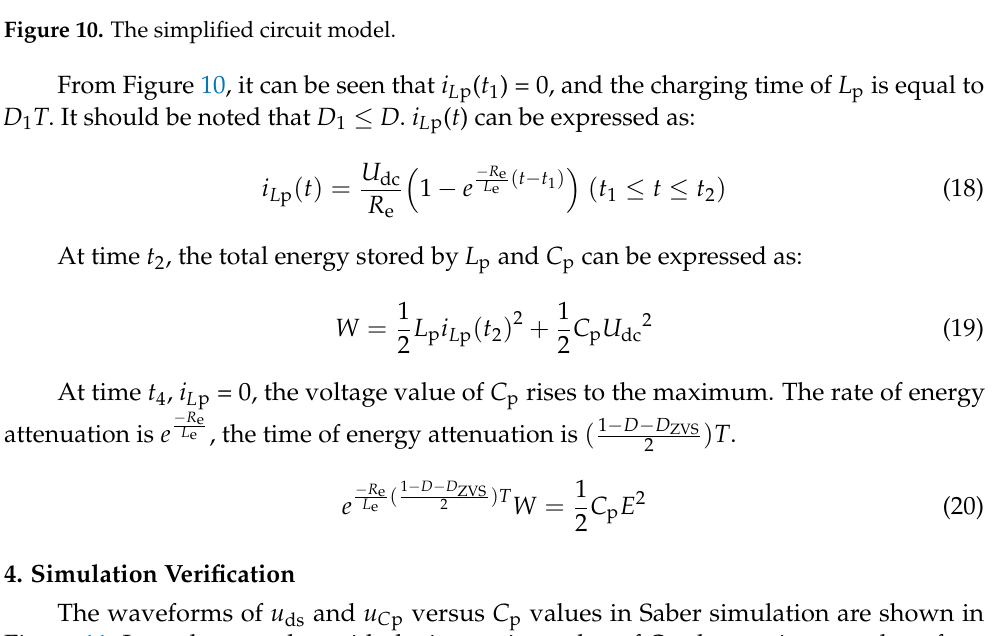
The waveforms of u ds and u C p versus C p values in Saber simulation are shown in Figure 11. It can be seen that with the increasing value of C p , the maximum value of u ds decreases gradually, and the ZVS margin D ZVS decreases until it disappears. The theoretical calculation in Section 3 provides the basis for the actual value of C p . When the input DC voltage is 96 V and the switching frequency f is 85 kHz, in order to obtain a 5% ZVS margin, the peak voltage of C p should be about 240 V. As shown in Figure 11b, when other circuit parameters are determined, the value of C p is changed continuously in Saber simulation until the value of u C p is about 240 V, and C p = 64.5 nF. When C p = 64.5 nF, the ZVS margin measured in the simulation is about 5.5%, which is close to the design target of 5%, indicating that the calculation method is reliable in Section